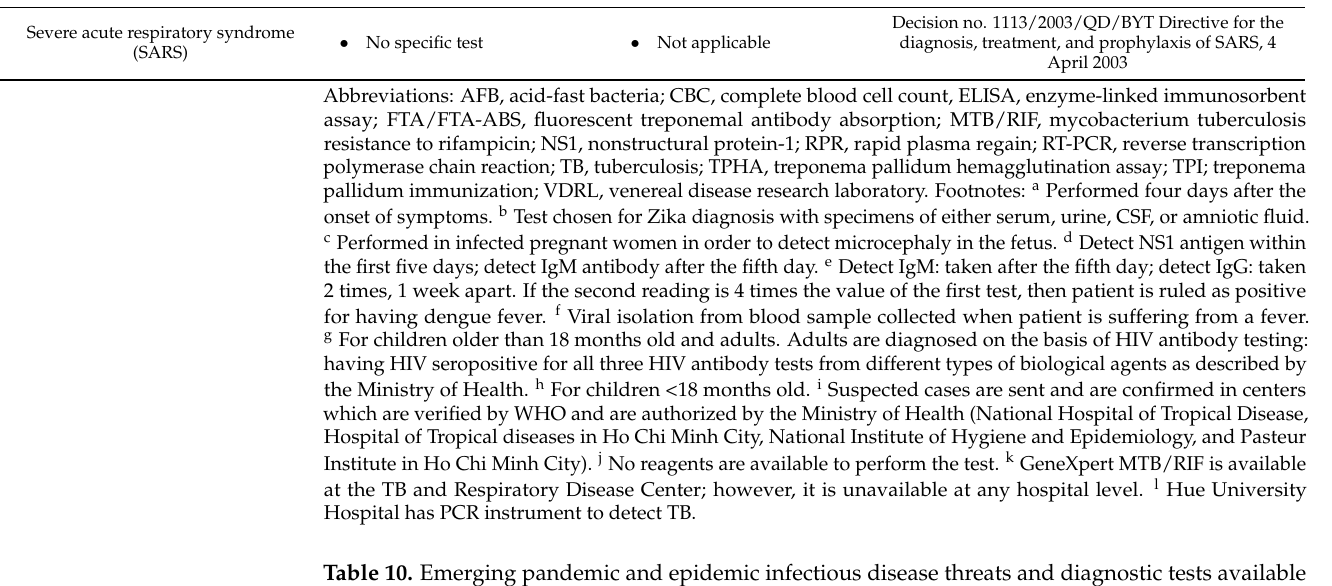
Table 10. Emerging pandemic and epidemic infectious disease threats and diagnostic tests available in Central Vietnam